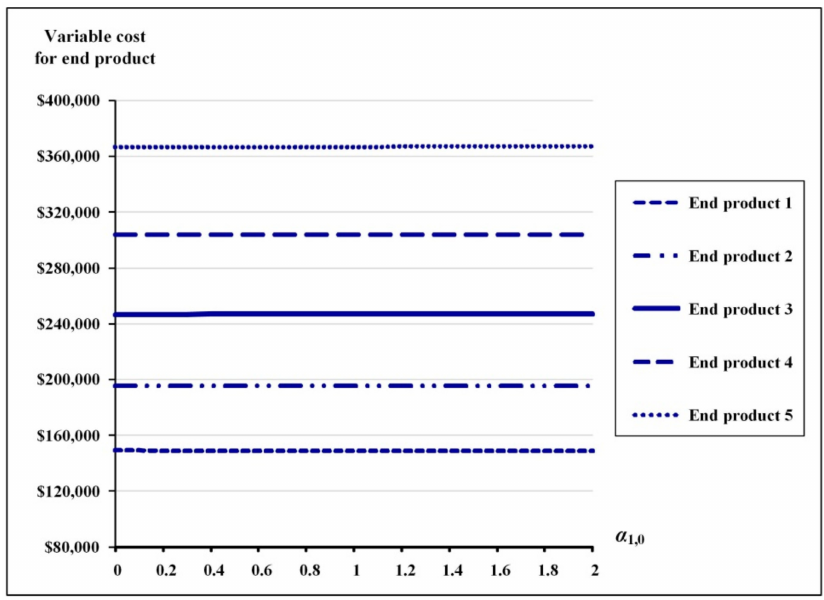
Figure 11. Variable production cost for each end product regarding α 1,0.